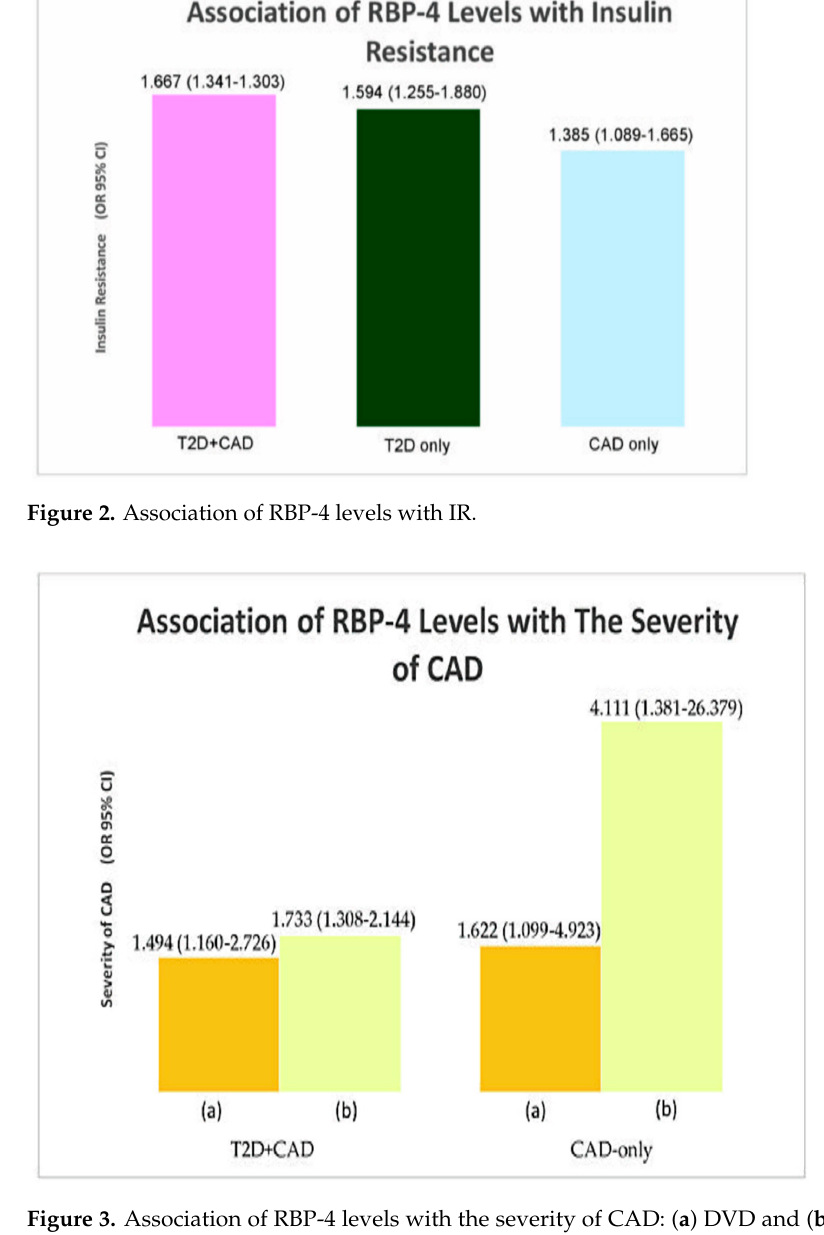
Figure 3. Association of RBP-4 levels with the severity of CAD: ( a ) DVD and ( b ) TVD; SVD is the reference group.